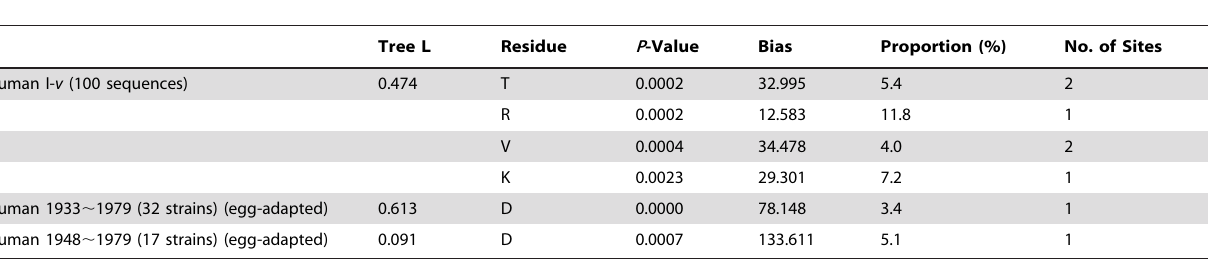
Table 8. Directional selection analysis on human A(H1N1)